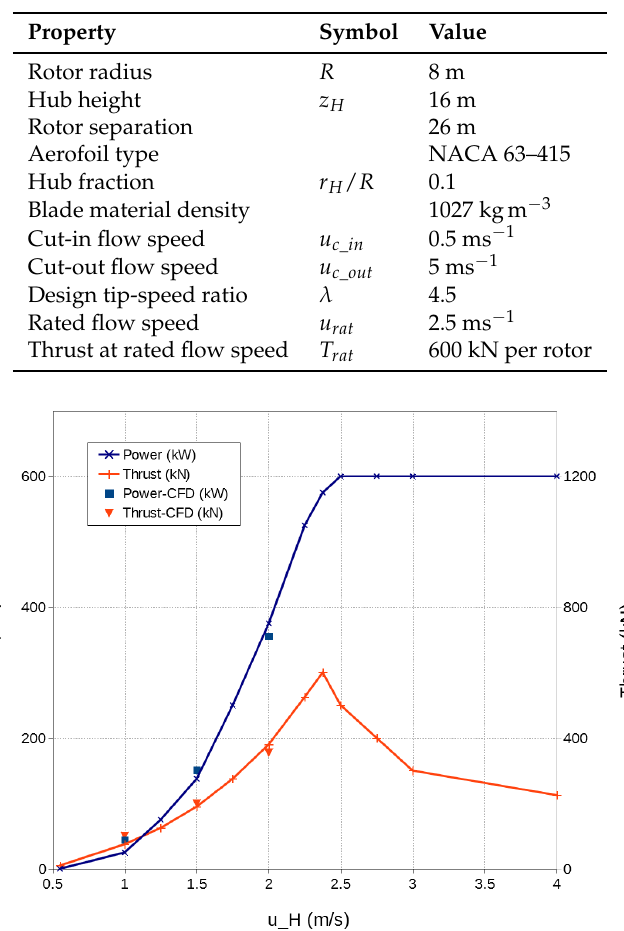
Table 1. General specifications for the modelled turbine.